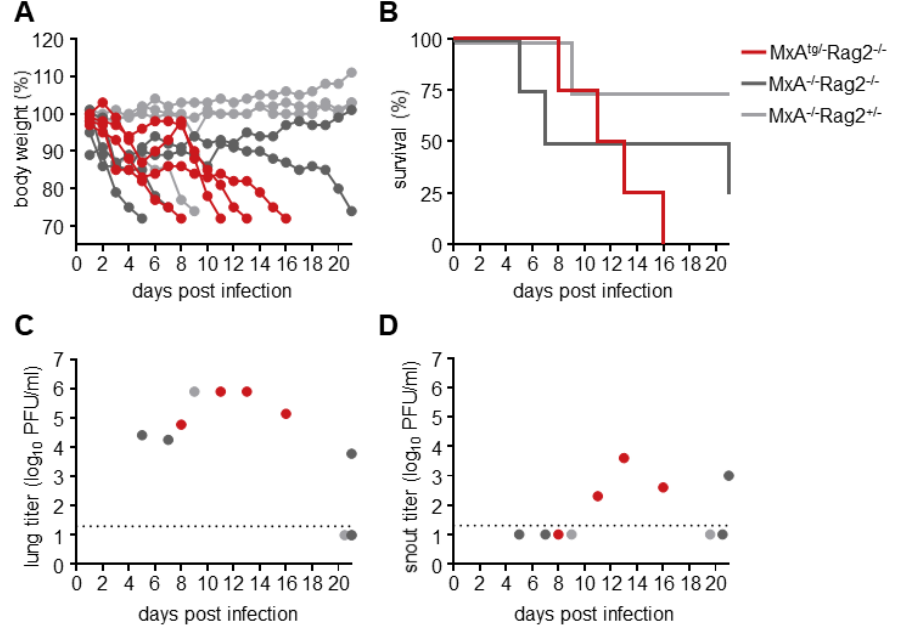
Figure 2. Rag2 -/- mice support prolonged IAV infection. ( A , B ) MxA tg/- Rag2 -/- mice and MxA -/- mice with and without functional Rag2 (n = 4 each) were infected intranasally with 40 µL of 0.2 × LD 50 depending on their MxA genotype (10 4 PFU for MxA tg/- and 4 PFU for MxA -/- ). Body weight changes ( A ) and survival rates ( B ) were monitored for 21 days. Mice were sacrificed once their weight fell below 75% of the initial body weight. At the day of death (or on day 21 for the surviving mice) lungs ( C ) and snouts ( D ) were harvested to determine viral titers and to isolate virus for further analysis.